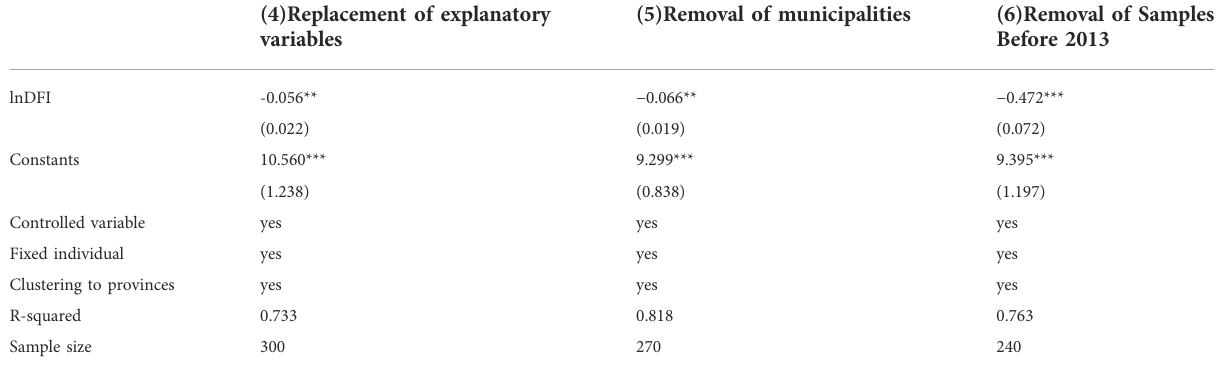
TABLE 4 Robustness test